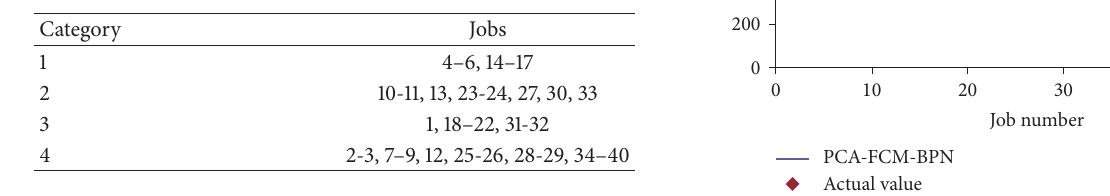
Table 6: The classifying results (𝜇 𝐿 = 0.3) .